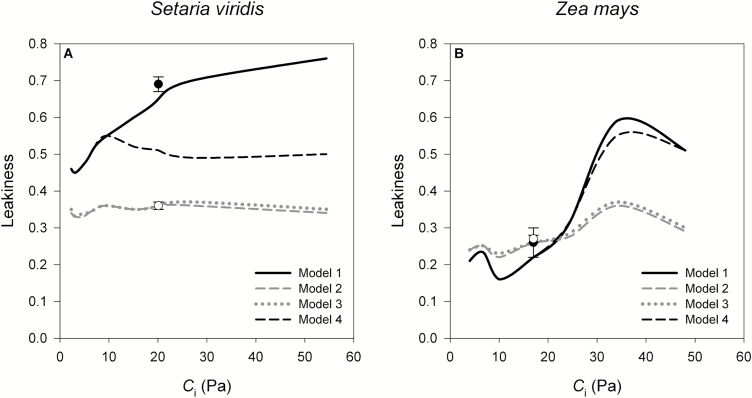
Effect of different parameterizations of models of photosynthesis in the calculation of leakiness (ϕ) in (A) Setaria virids and (B) Zea mays at 25 °C and over a range of pCO2 inside the leaf intercellular spaces (Ci). Model 1 (solid black line) uses in vitro Vpmax and gm finite and equal to the values presented in Fig. 3; Model 2 (dashed grey line) uses in vivo Vpmax (which is variable with pCO2, see Supplementary Fig. S2) and gm infinite; Model 3 (dotted grey line) uses the same as Model 1 but the solution was only constrained by A and not Δ13C; Model 4 (dashed black line) uses the same as Model 1 but introducing Vpr (= 64 and 59 μmol m–2 s–1 in Setaria and Zea, respectively) in the calculation of Vp (Eqn 6). The rest of the variables included in these models were calculated as explained in the Methods section: values for some of them can be found in Supplementary Fig. S2. In Models 1, 2, and 4, ϕ was calculated with Eqns 14 or 16 (same result) and in Model 3, ϕ was calculated with Eqn 14. The symbols indicate the value of ϕ at ambient air pCO2 calculated with the simplified Eqn 19 assuming either gm finite (solid symbols) or infinite (clear symbols). Values are means ±SE; n=4 in Setaria, n=3 in Zea.